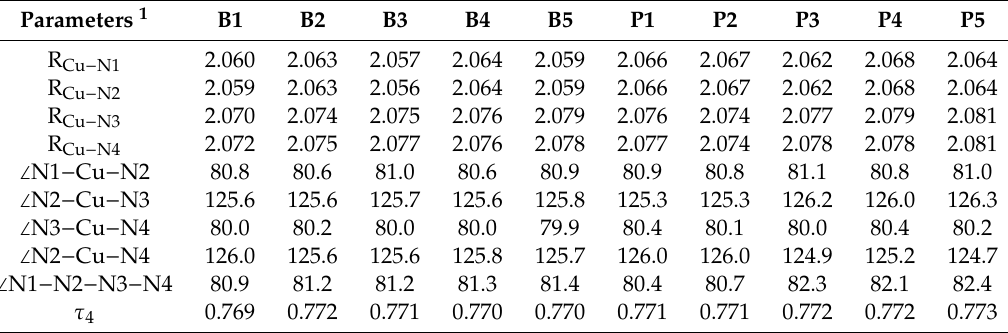
1 Bond lengths are in angstroms and angles are in